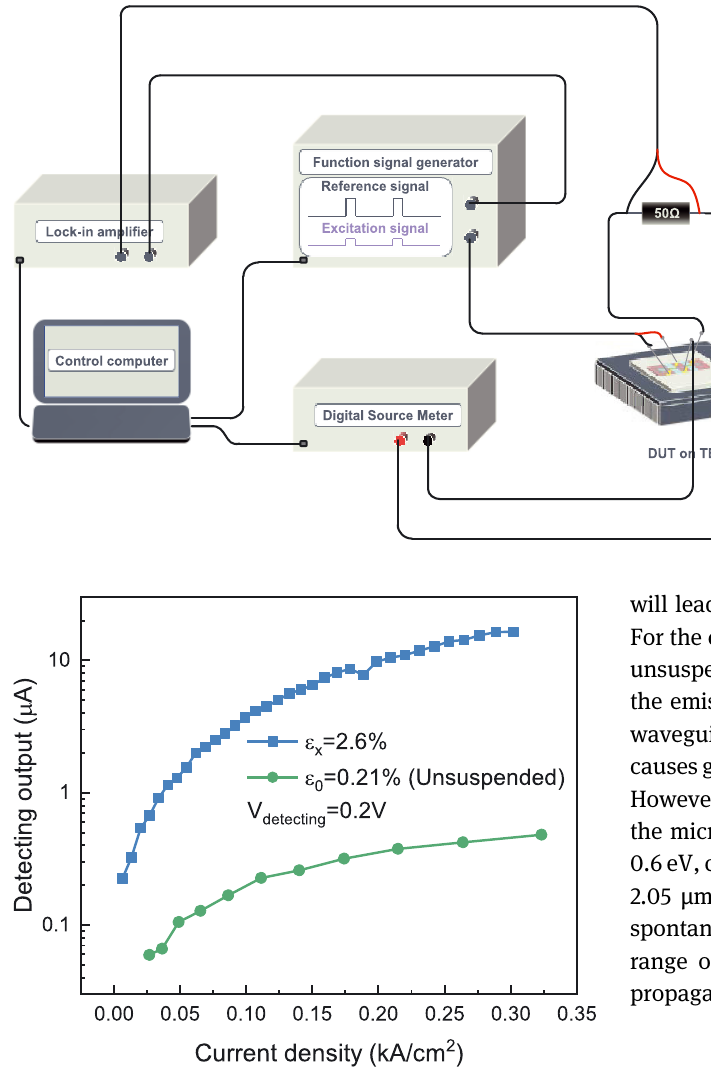
Figure 8: Comparison of the output from the detecting microbridge betweenthesuspendeddevicewith ε x =2.6%andtheunsuspended device with a reverse bias voltage of 0.2 V on the detecting p – i – n junction, at room temperature. For the current density of 0.3 kA/cm 2 at the emitting part, the injected carrier density is 4.6 × 10 16 cm − 3